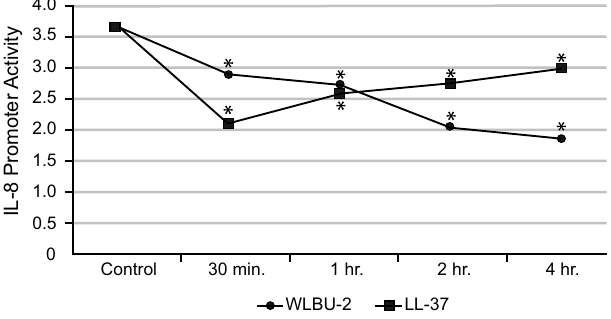
Figure 3. eCAPs show decreased in vitro IL-8 promoter activity in LPS-stimulated cells. CF IB3-1 ( Δ F508/W1282X) cells